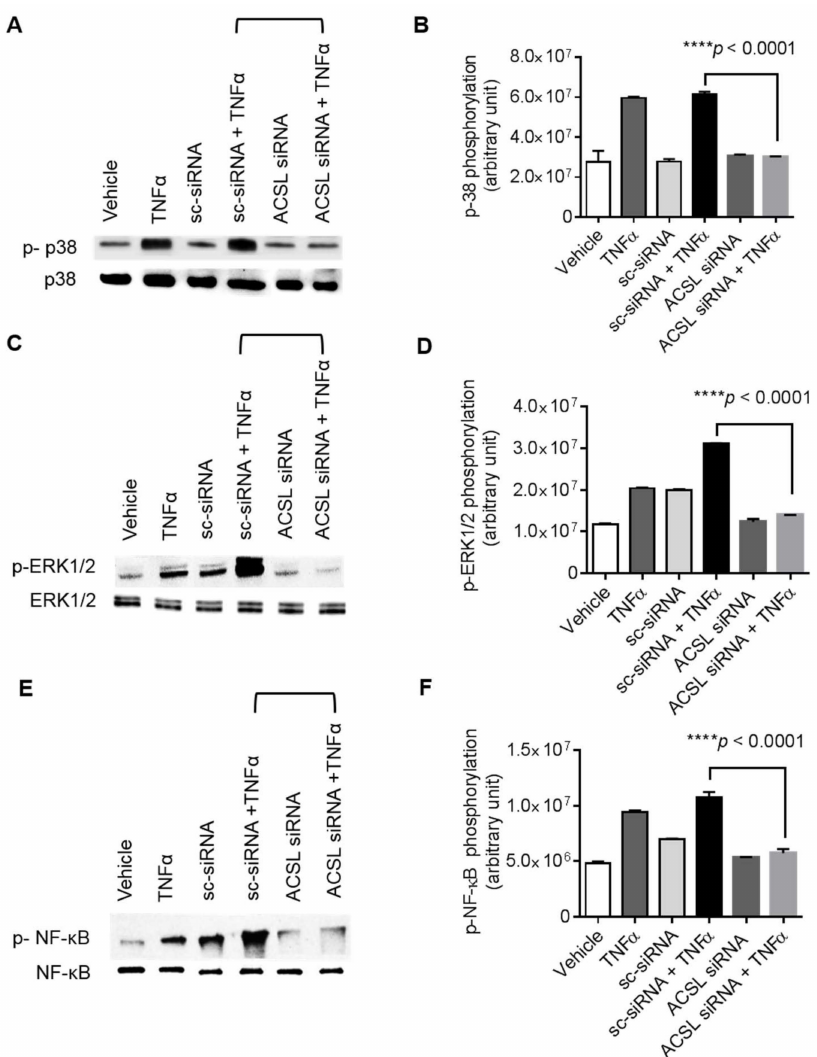
Figure 6. ACSL1 siRNA knockdown reduces the TNF α induced phosphorylation of p38 MAPK, ERK1 / 2, and NF- κ B. MDA-MB-231 cells were transfected with ACSL1 siRNA (targeting the human ACSL1 gene expression) or scramble siRNA (a control siRNA) and incubated for 36 h. ACSL1